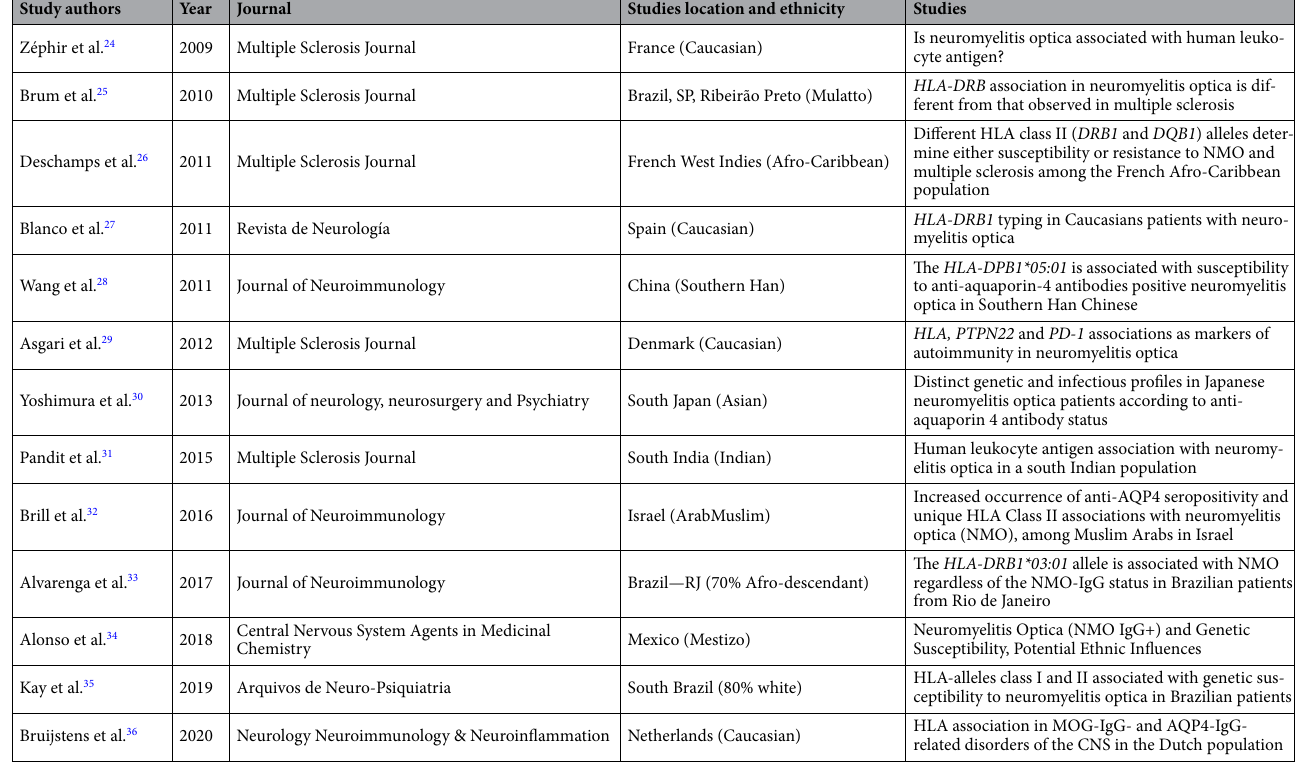
Table 1. Articles included in the systematic